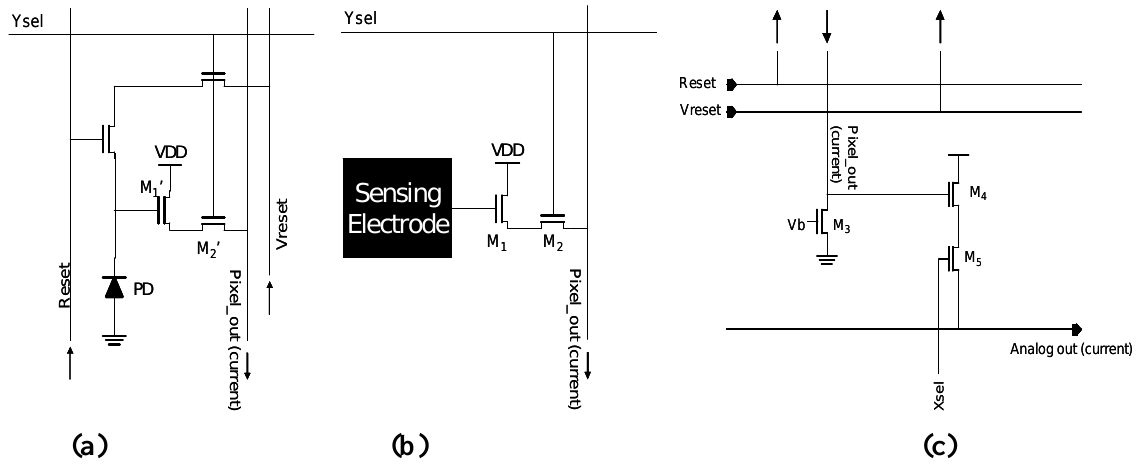
Figure 2. Schematic diagrams of (a) an optical sensing pixel (APS) and (b) a passive electric sensing pixel (capacitive coupling) with (c) columnar readout circuitry (adapted from [1]).